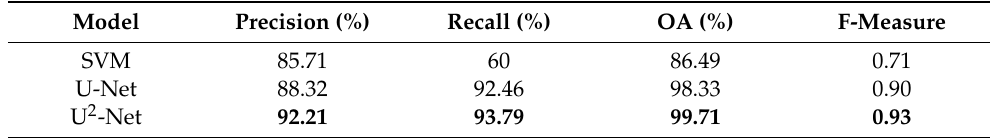
Table 6. Accuracy evaluation of the SVM-based method, U-Net deep learning model-based method, and U 2 -Net deep learning model-based method, and the best value is represented in